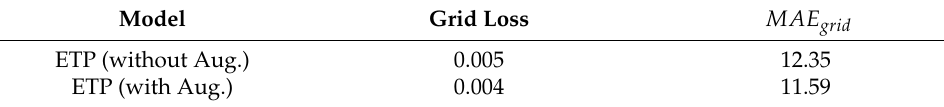
Table 7. Effects of the augmentation on